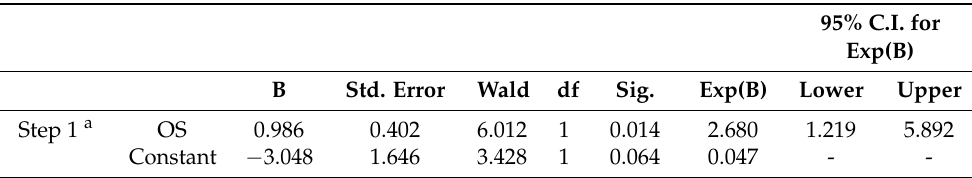
Table 19. Organisation size: regression analysis for lasS.